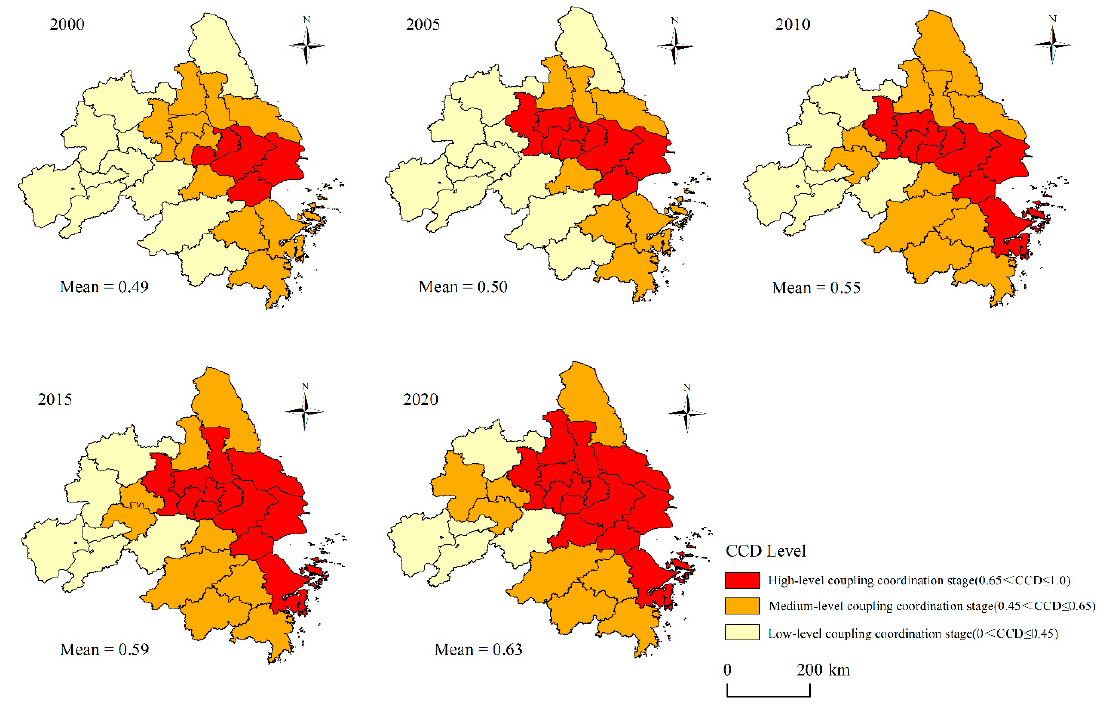
Figure 7. Spatiotemporal changes of CCD in the YRDUA.